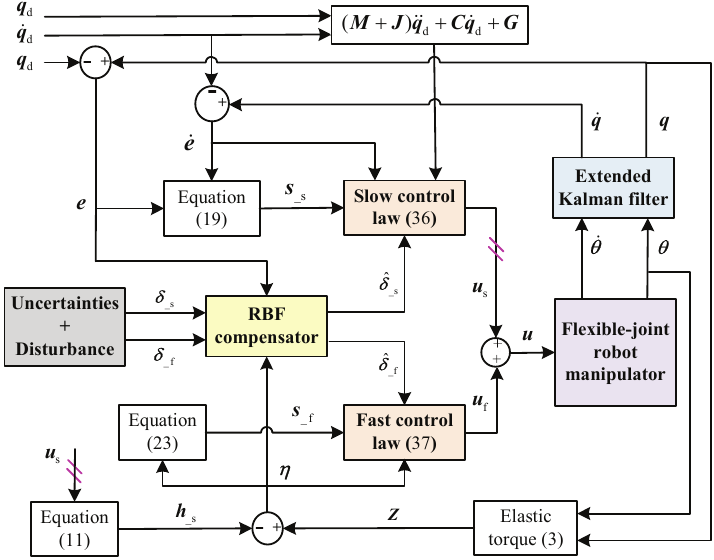
Figure 2. Block diagram of the proposed